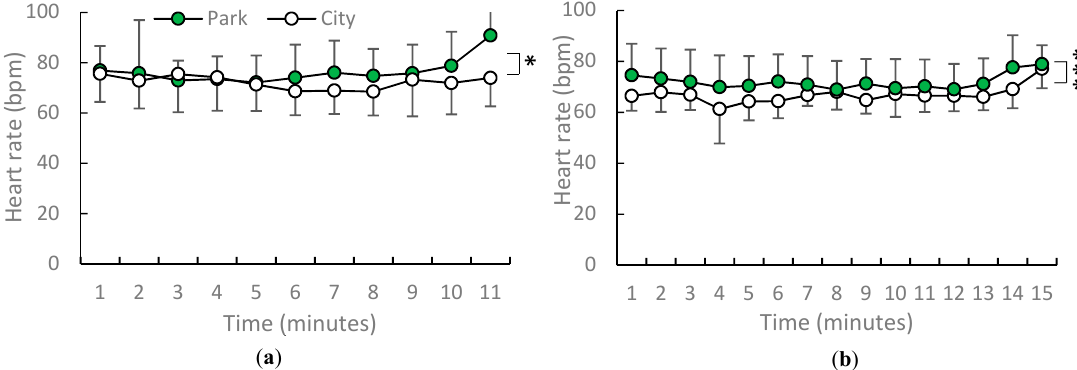
Figure 4. Average systolic and diastolic blood pressure after urban park and city views in early summer. N = 12, mean ± standard deviation. * p < 0.05, determined by paired t -test (one-sided).